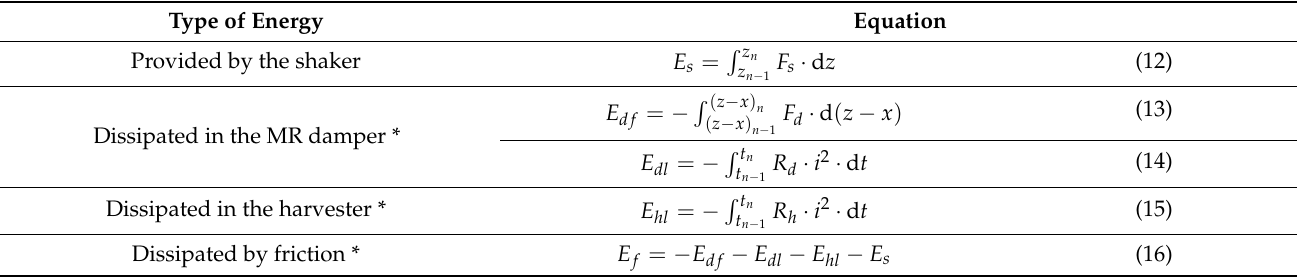
Table 2. Type of energy and governing equation in one cycle.